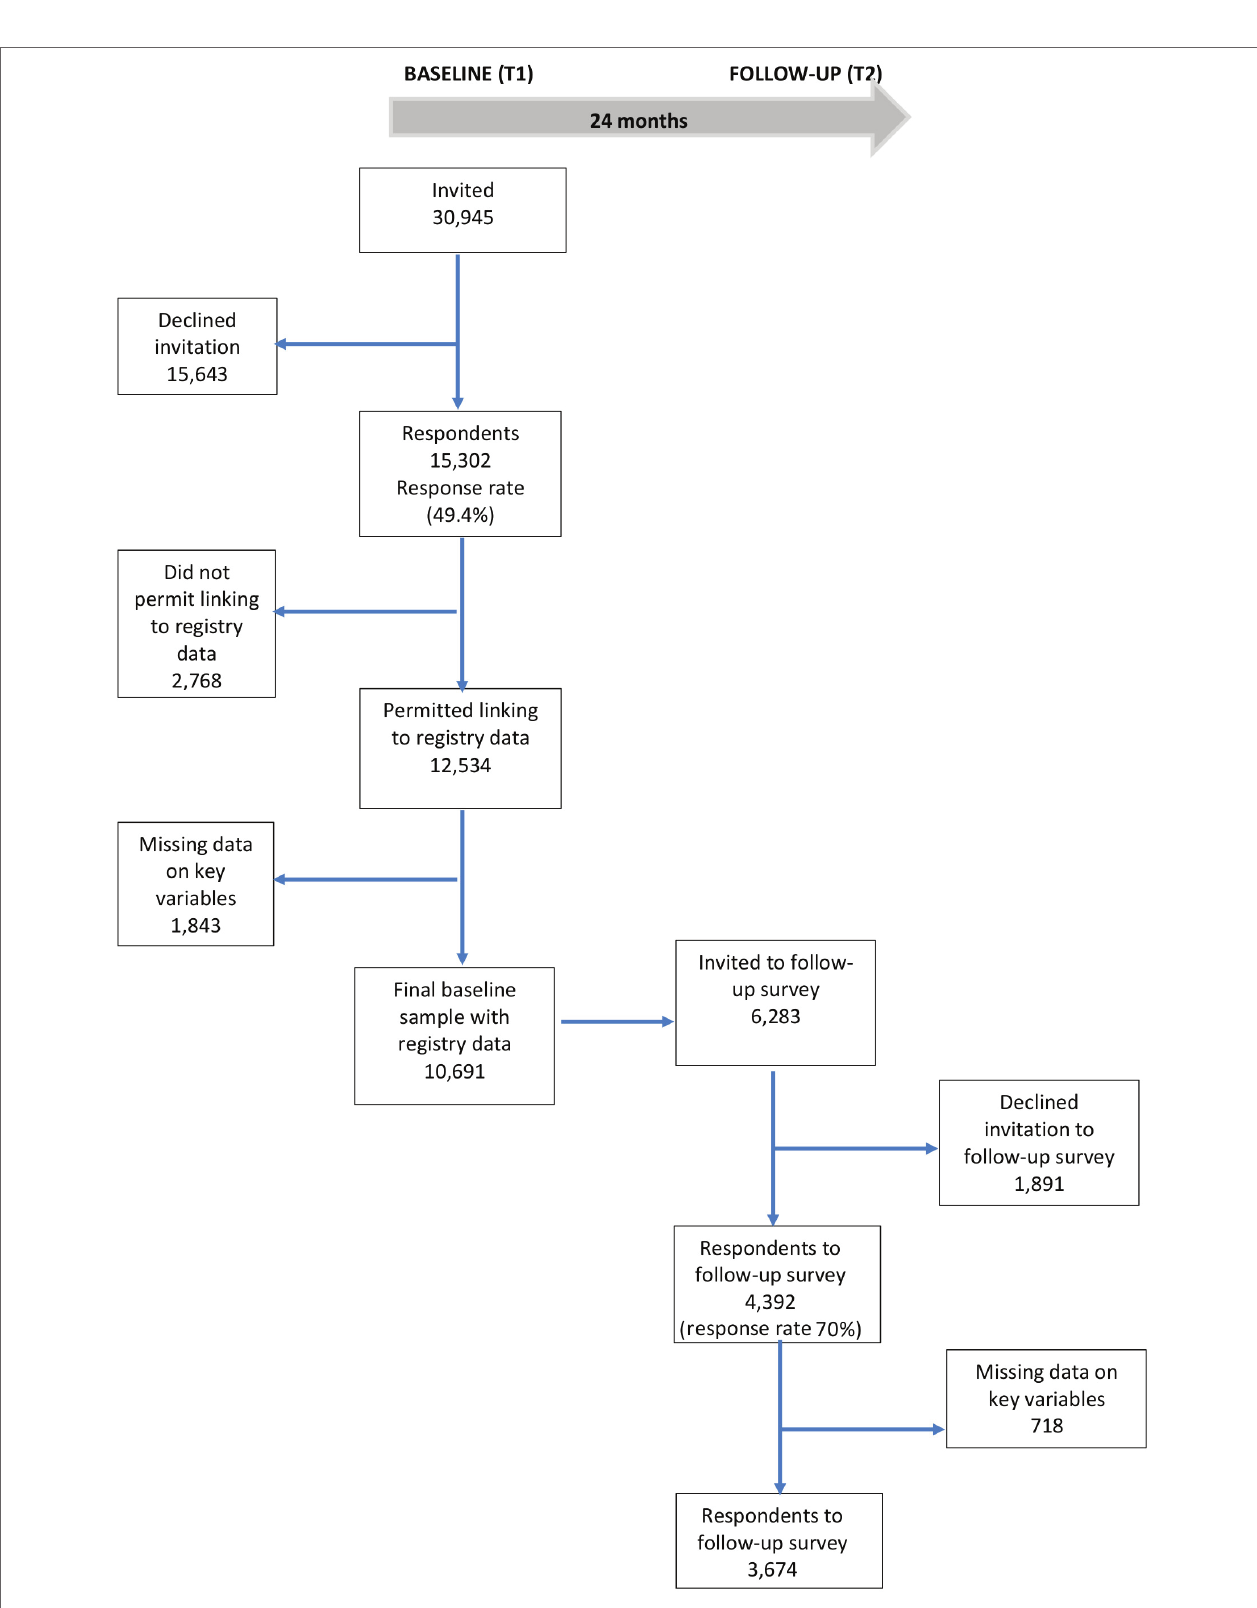
FIGURE 1 | Flow chart for